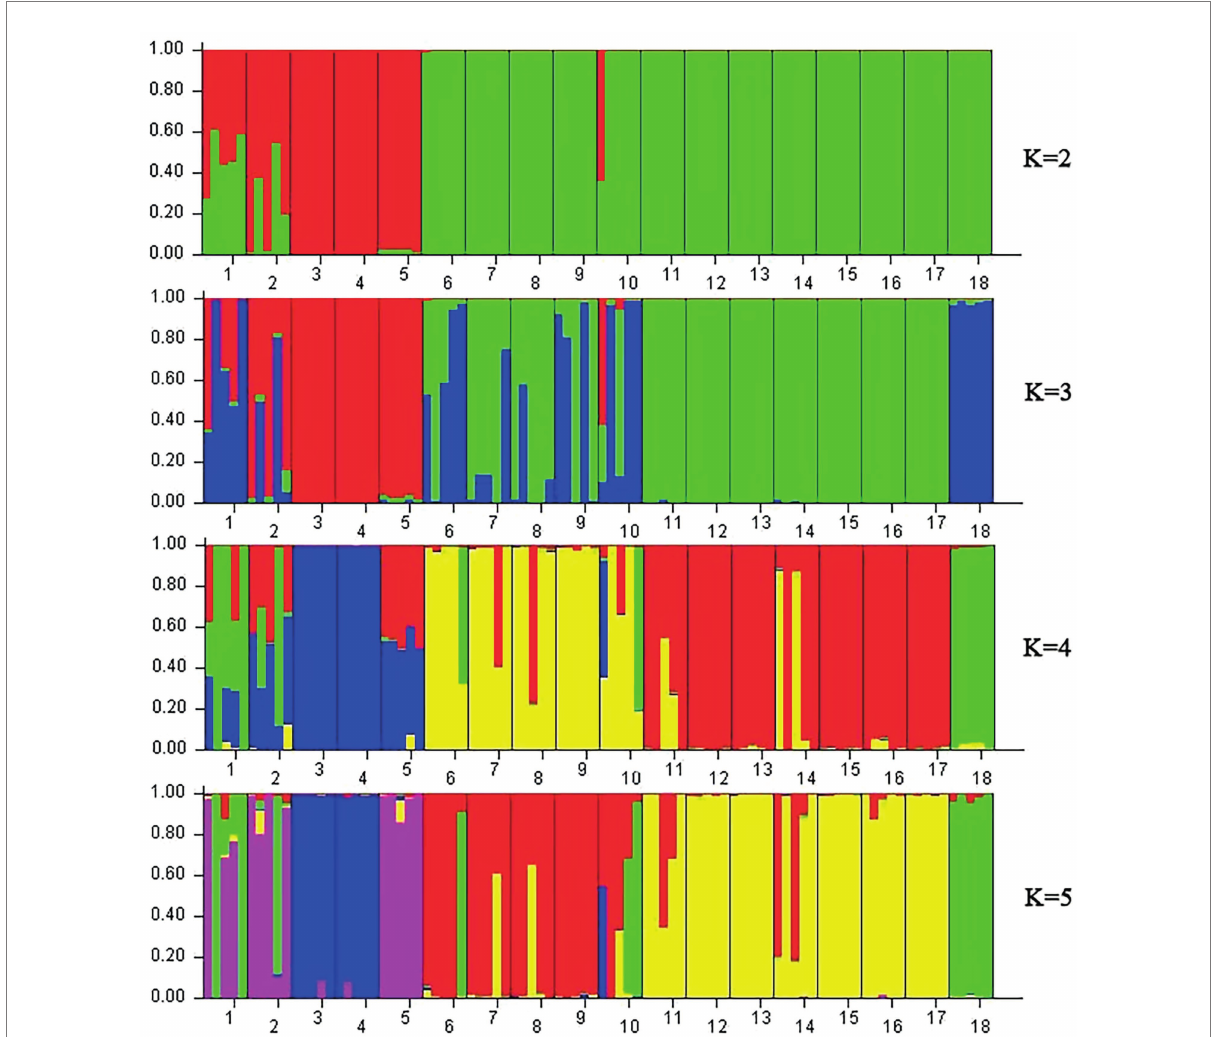
FIGURE 7 STRUCTURE analysis based on Bayesian clustering according to cpDNA data. Note: Nos. 1–18 represent populations HZP, YML, HCX, CKX, TPY, BQY, WSG, TJG, LJTL, HTDL, JX, ZX, LS, XYL, MNL, MP, FH, and SNH,